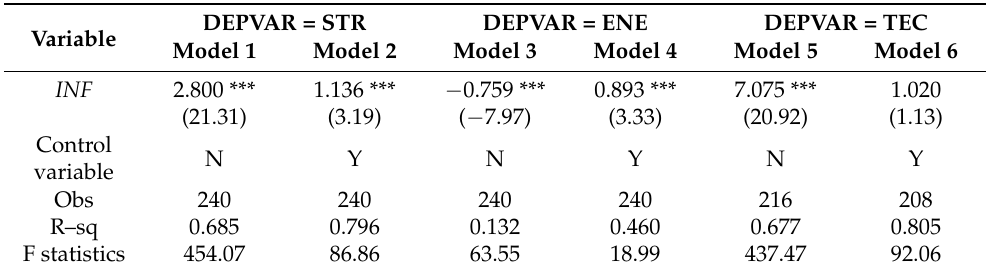
Table 7. Results of the impact